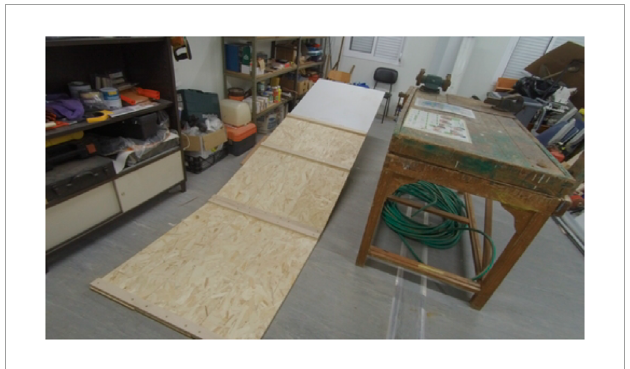
FIGURE 2 Wooden structure of the ramp.